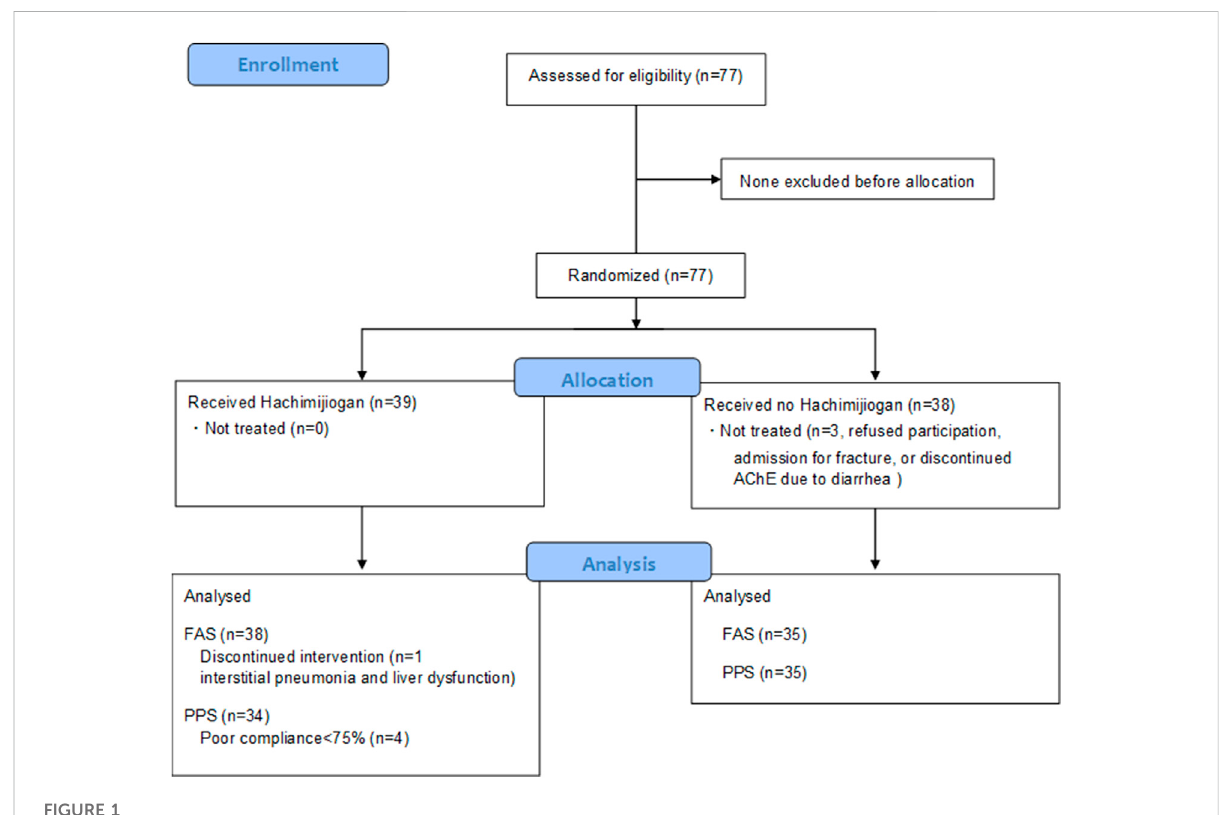
FIGURE 1 Enrollment, Randomization, and Trial completion.